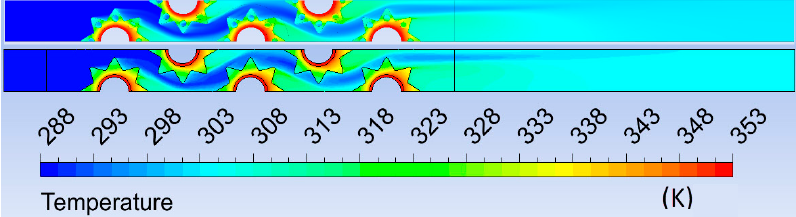
Figure 4. Temperature fields for perforated and non-perforated fins.